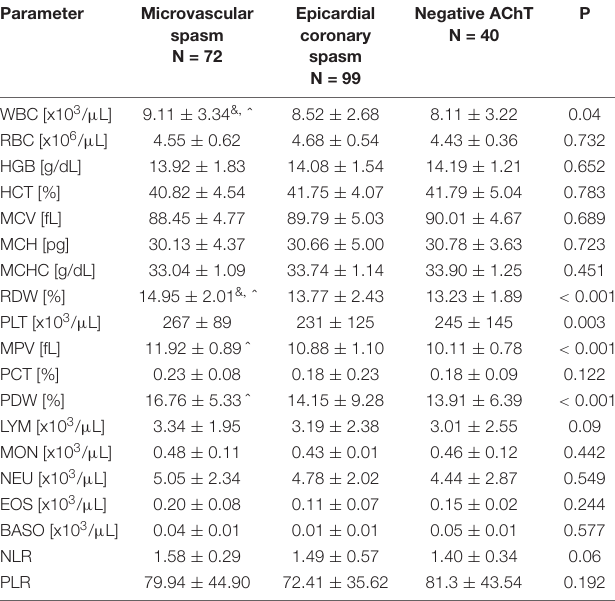
TABLE 2 | Comparison of values of 20 complete blood count parameters between groups.